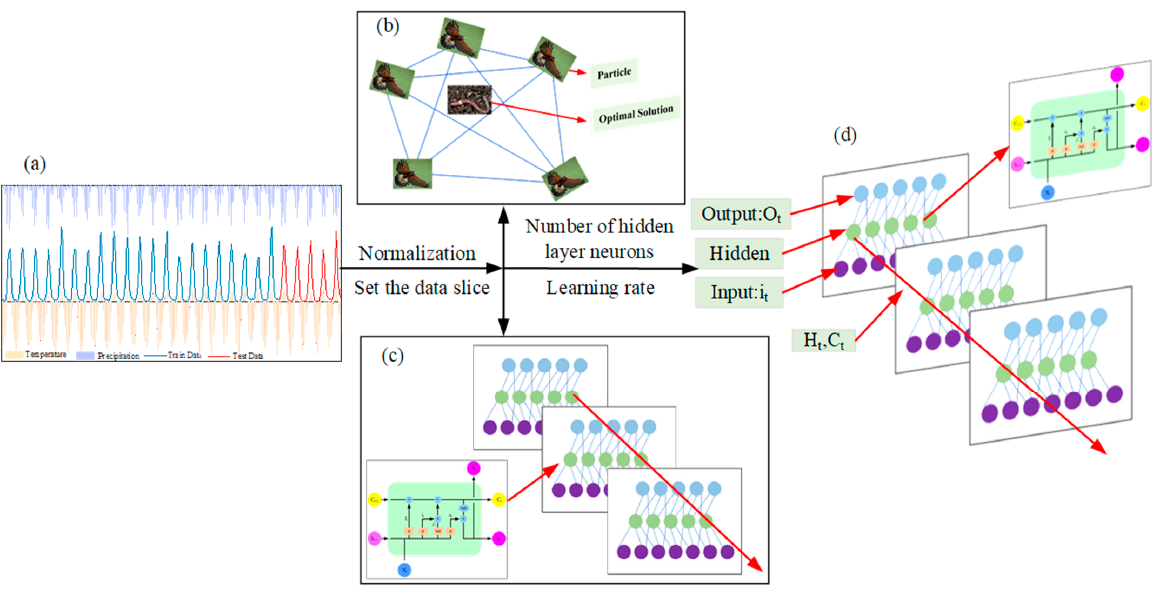
Figure 3. PSO-LSTM model construction process. ( a ) Data preparation, mainly including data standardization and slicing; ( b ) Schematic diagram of the social network structure of the PSO algorithm; ( c ) Schematic diagram of the initial LSTM model structure; ( d ) The PSO-LSTM model after parameter optimization.